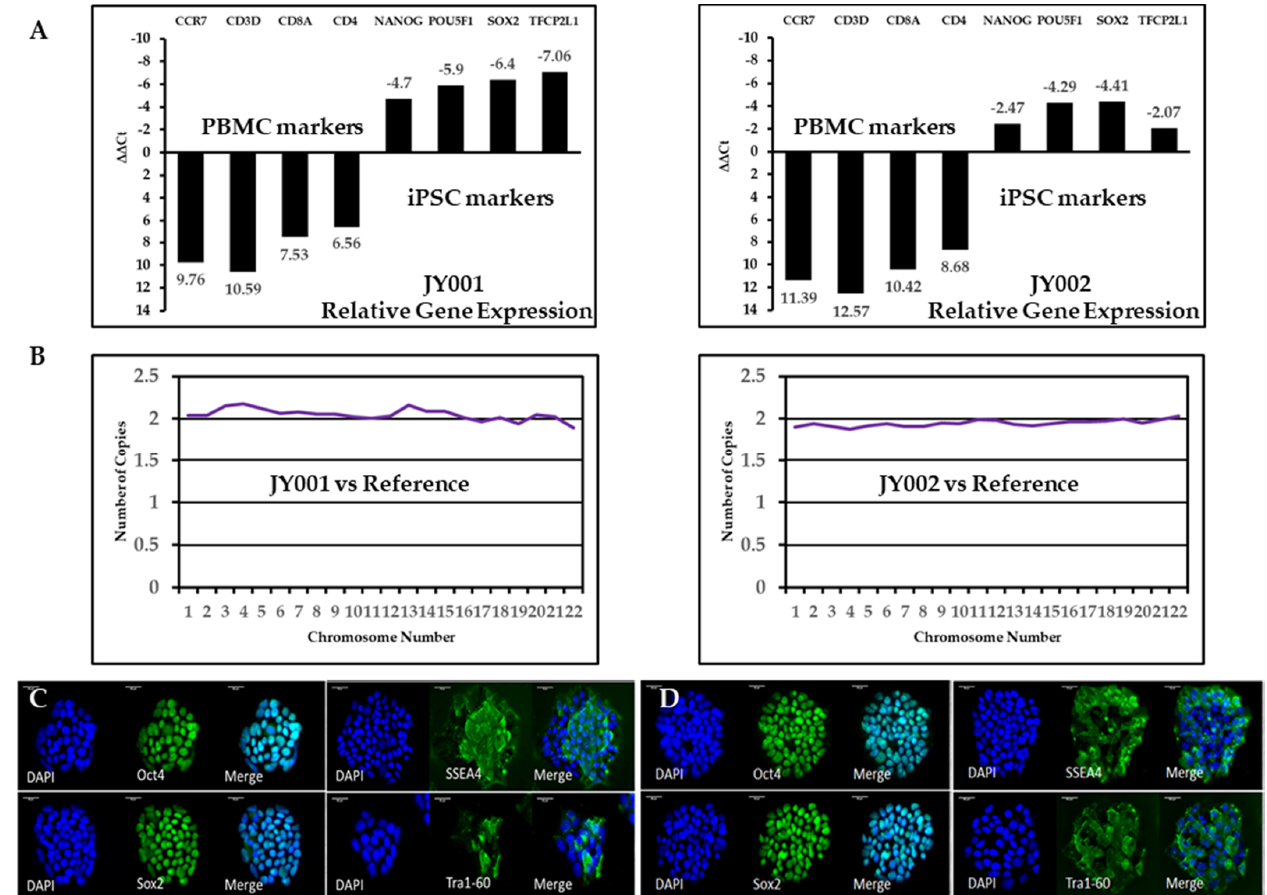
Figure 2. Validation of iPSC lines. ( A ) RT-PCR analysis. In both iPSC lines, pluripotent cell markers of NANOG, POU5F1 (OCT4), SOX2, and TFCP2L1 are upregulated; on the other hand, blood cell markers of CCR7, CD3D, CD8A, and CD4 are greatly reduced. ( B ) Molecular karyotyping. To screen for aneuploidy, we performed molecular karyotyping for all human chromosomes. Both iPSC lines had the expected number of copies for auto chromosomes (22 pair). Sex chromosome data are not shown here. ( C ) Normal sibling-derived human iPSC and ( D ) patient-derived iPSC carrying the c.2299delG mutation were stained with the nuclear pluripotent stem cell markers of OCT4, SOX2, SSEA4, and TRA1-60. Cell nuclei were counterstained with DAPI. The scale bar is 50 µ m in all